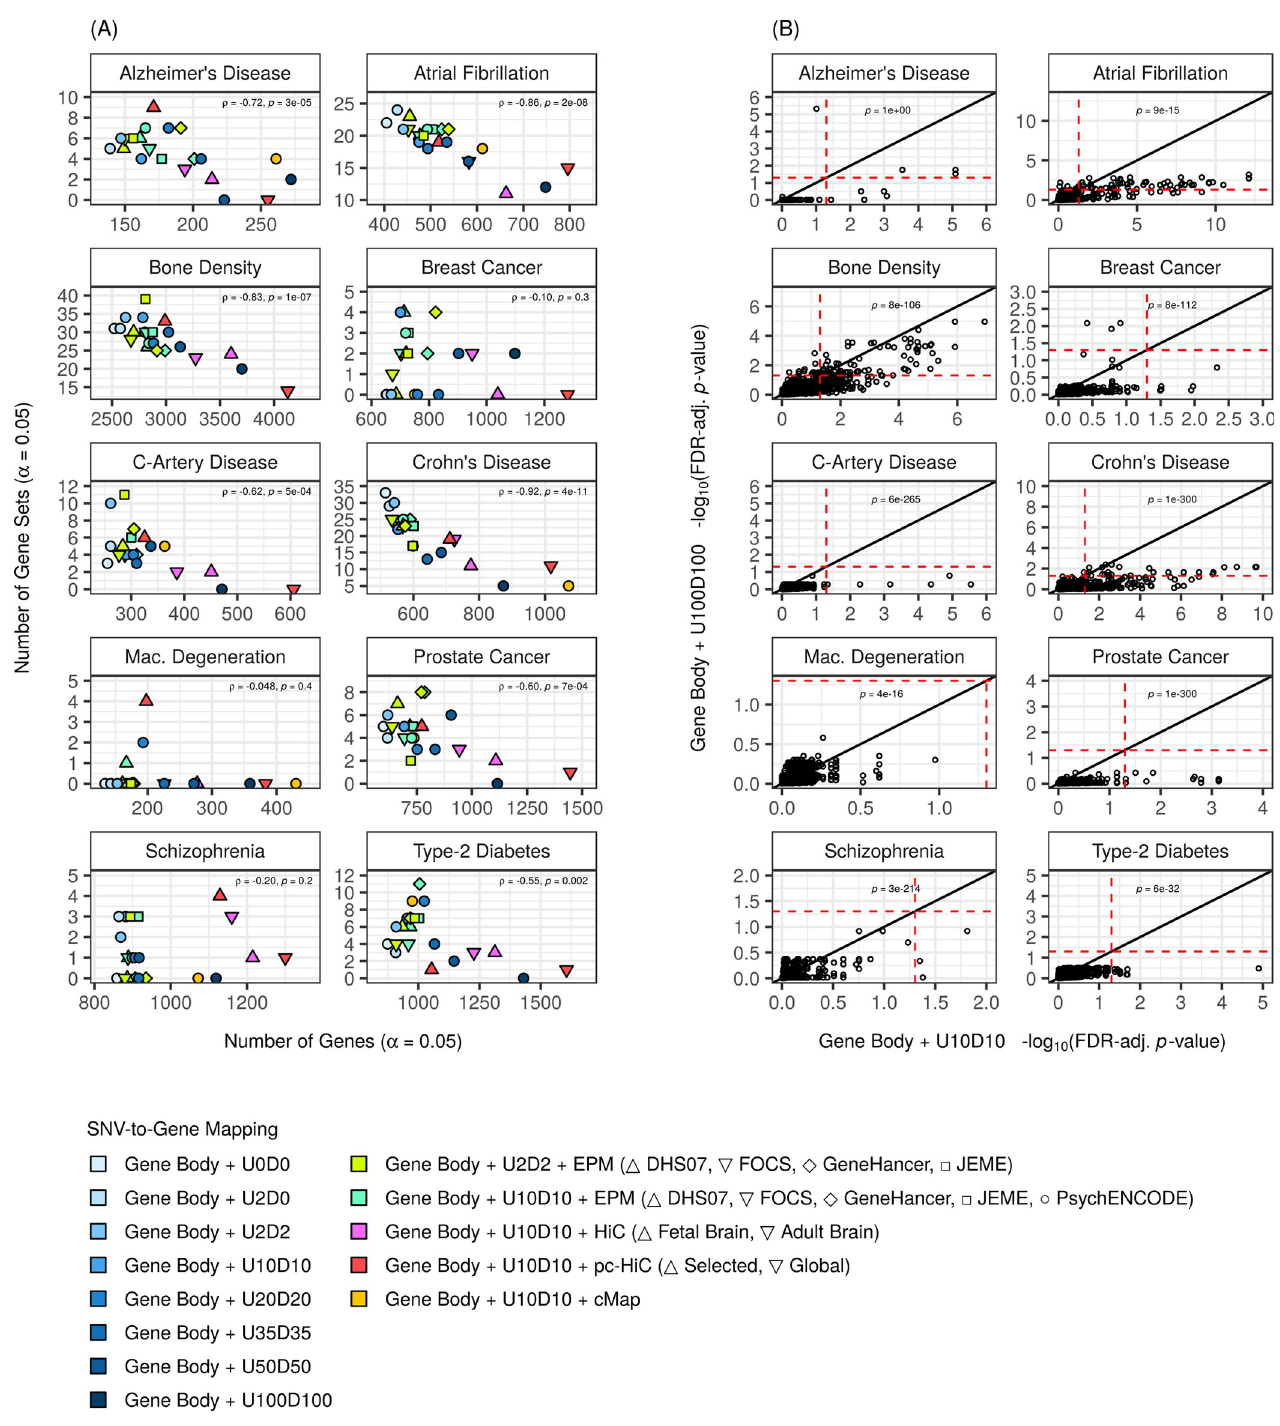
Fig 4. Mappings that yield more significant genes are associated with fewer significant gene sets. (A) The number of non-redundant, significant gene sets detected as a function of the number of significant genes detected for diverse mappings. For each phenotype, we reported Spearman’s rank correlation coefficient ( ρ ) and its associated p -value ( p ) for a test of negative correlation based on all mappings (including gene bodies with 250kb flanks, gene bodies with 500kb flanks, and gene bodies with 1000kb flanks, which are not depicted on the graphs themselves but provided in Table B in S6 Table). (B) Gene-set scores of individual gene sets (circles), comparing between a mapping with large flanks (that is, 100kb flanks) and a mapping with small flanks (that is, 10kb flanks, which is the baseline model). All gene sets are shown (irrespective of redundancy). Black, solid line shows the identity line. Red, dashed line shows the significance cut-off ( α = 0.05). We tested (one-sided, paired Wilcoxon test) if there was a tendency for gene-set scores to be attenuated with large